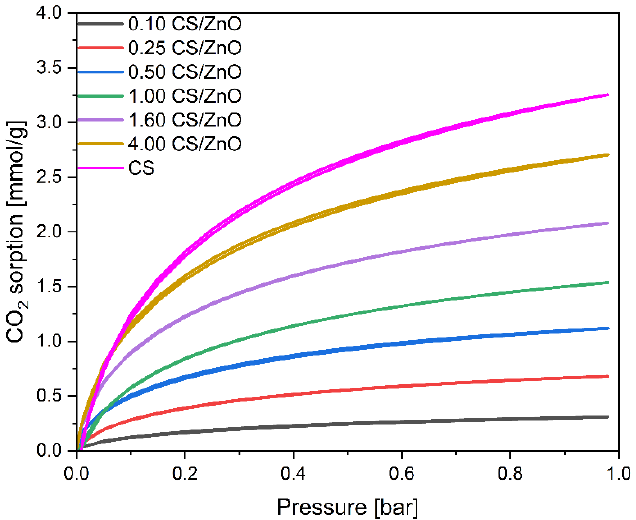
Figure 7. CO 2 sorption isotherms of the reference CS and the obtained CS/ZnO composites.